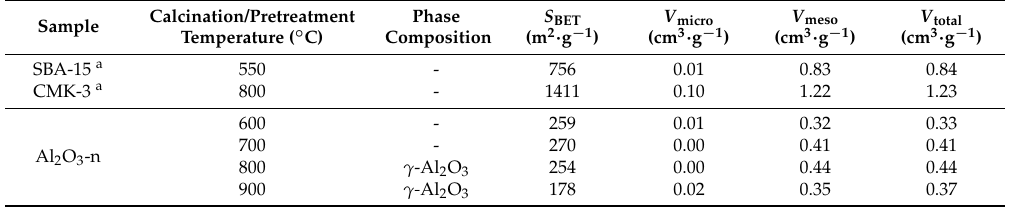
Table 1. Phase composition and textural properties of SBA-15, CMK-3 and mesoporous supports obtained by nanocasting. S BET : specific surface area; V micro : micropore pore volume; V meso : mesopore volume; V total : total pore volume.